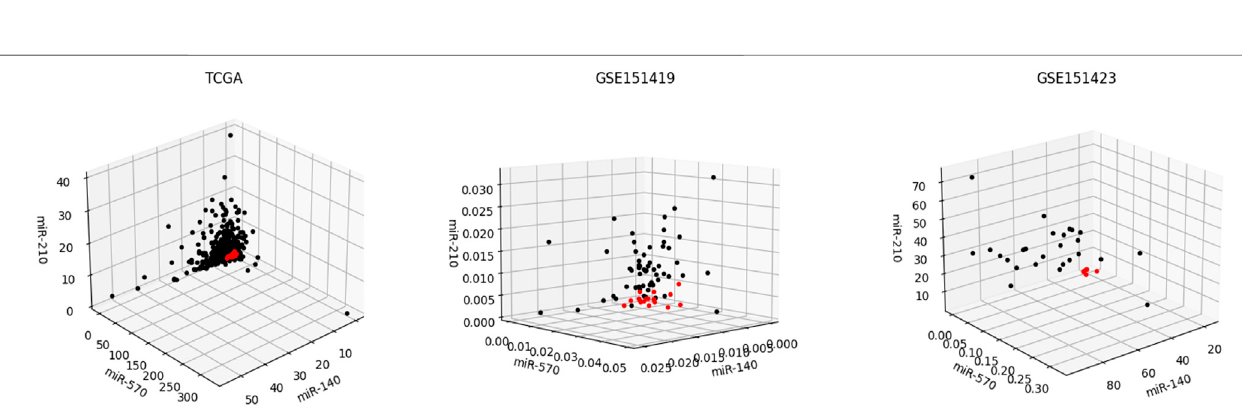
FIGURE 9 | Scatter plots of the expression levels corresponding miR-140, miR-570, and miR-210 on TCGA, GSE151419, and GSE151423.